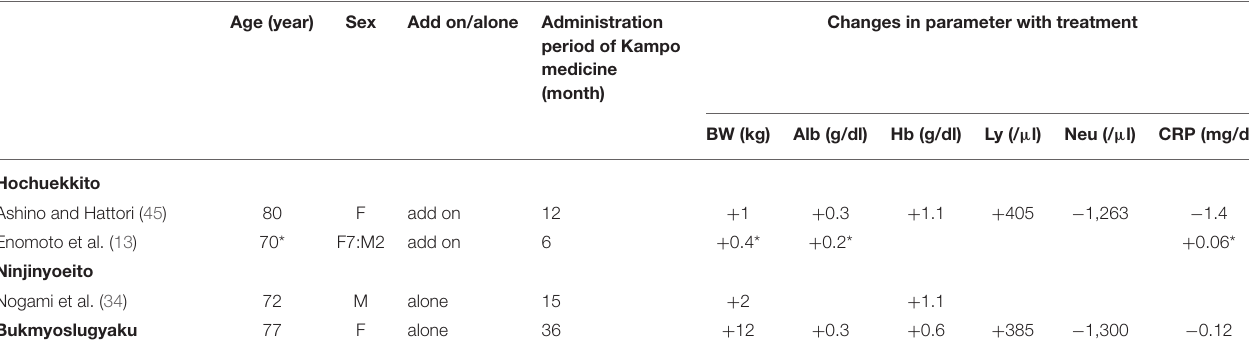
TABLE 2 | Comparison of previously reported data pre- and post- Kampo medicine treatment by hozai.